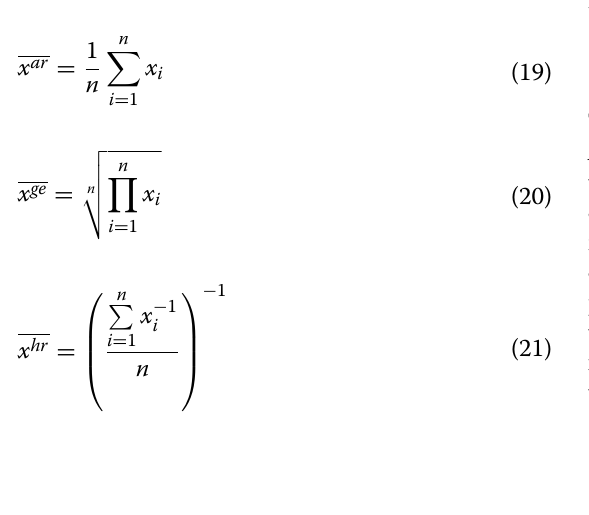
Table 2 The relationship between b Source‑to‑Site Distance Definition